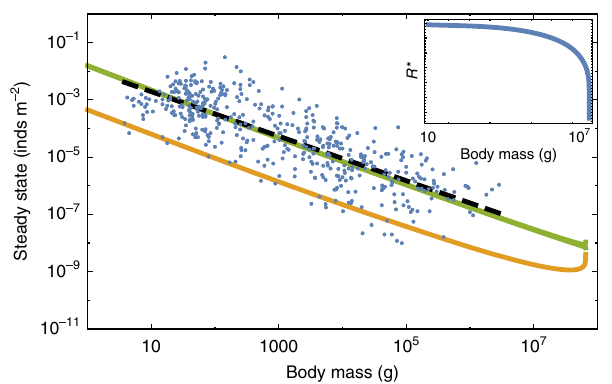
Fig. 4 Consumer steady states F * (green) and H * (orange) as a function of body mass along with the data from Damuth 25 . Inset: resource steady state R * as a function of consumer body